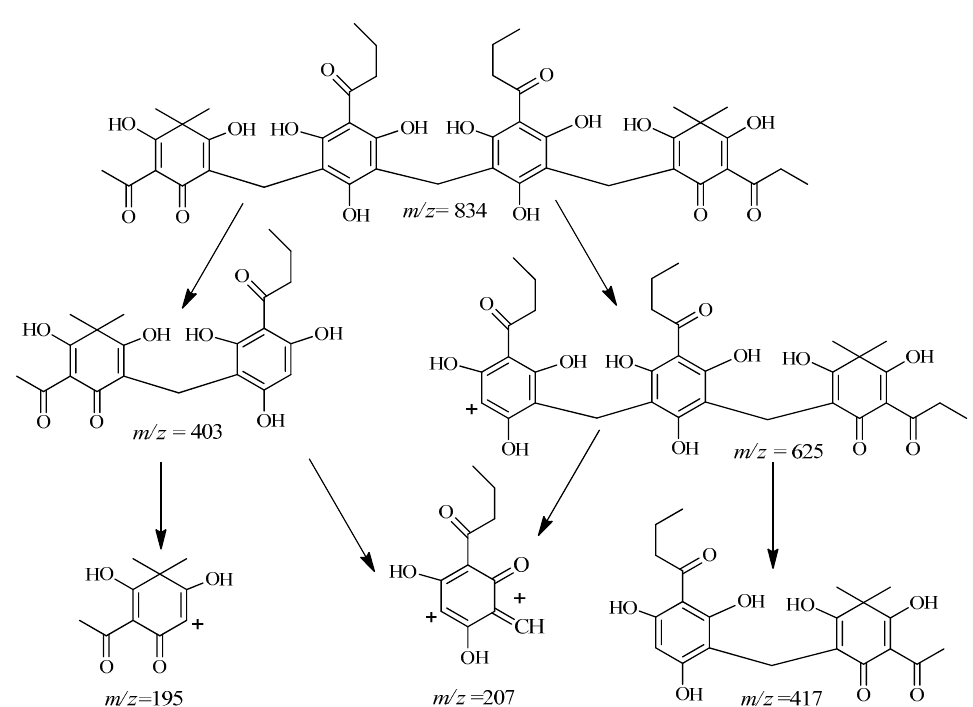
Scheme 1. Electrospray Ionization Mass Spectroscopy (ESIMS) fragments of compound 7